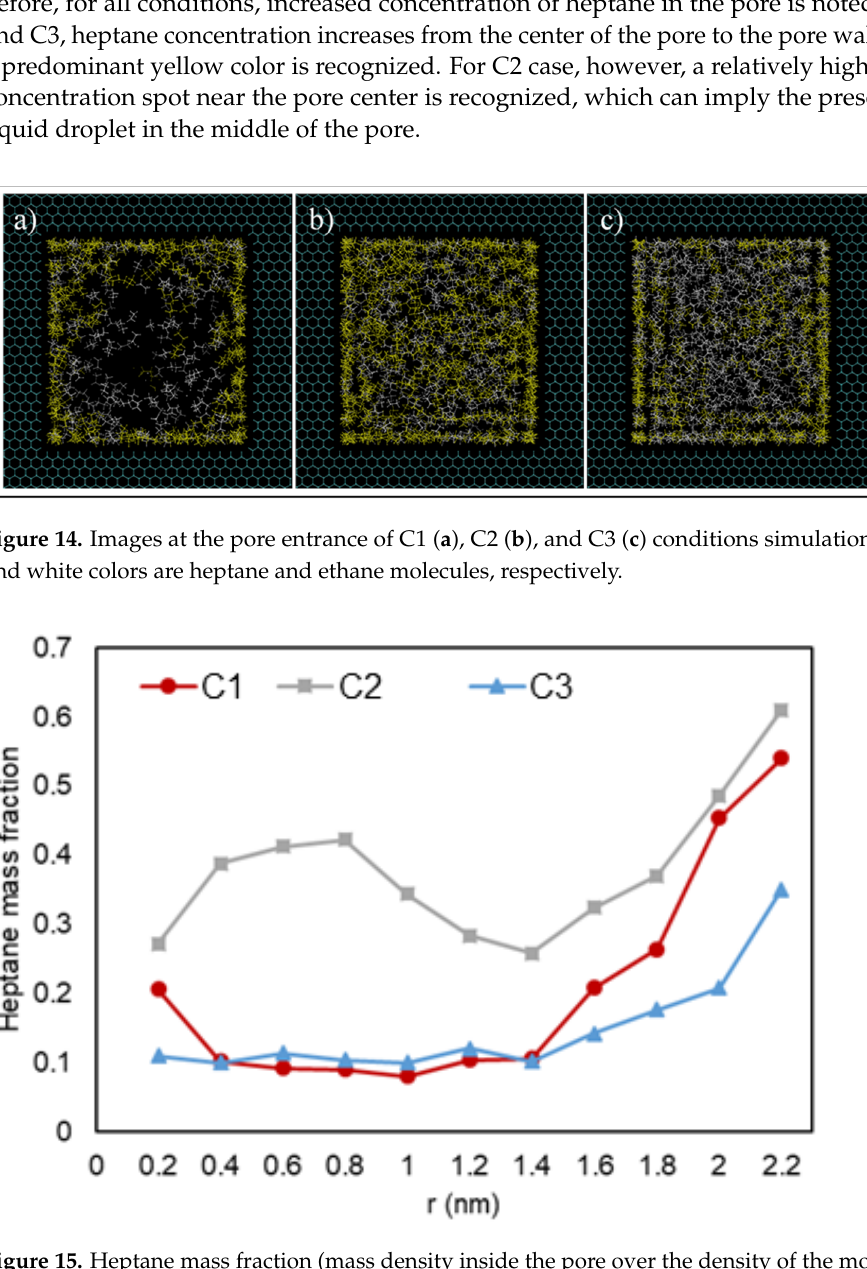
Figure 15. Heptane mass fraction (mass density inside the pore over the density of the molecules in bulk conditions) vs. radial position in C1 (gas phase in bulk), C2 (two-phase in bulk), and C3 (liquid phase in bulk) conditions.